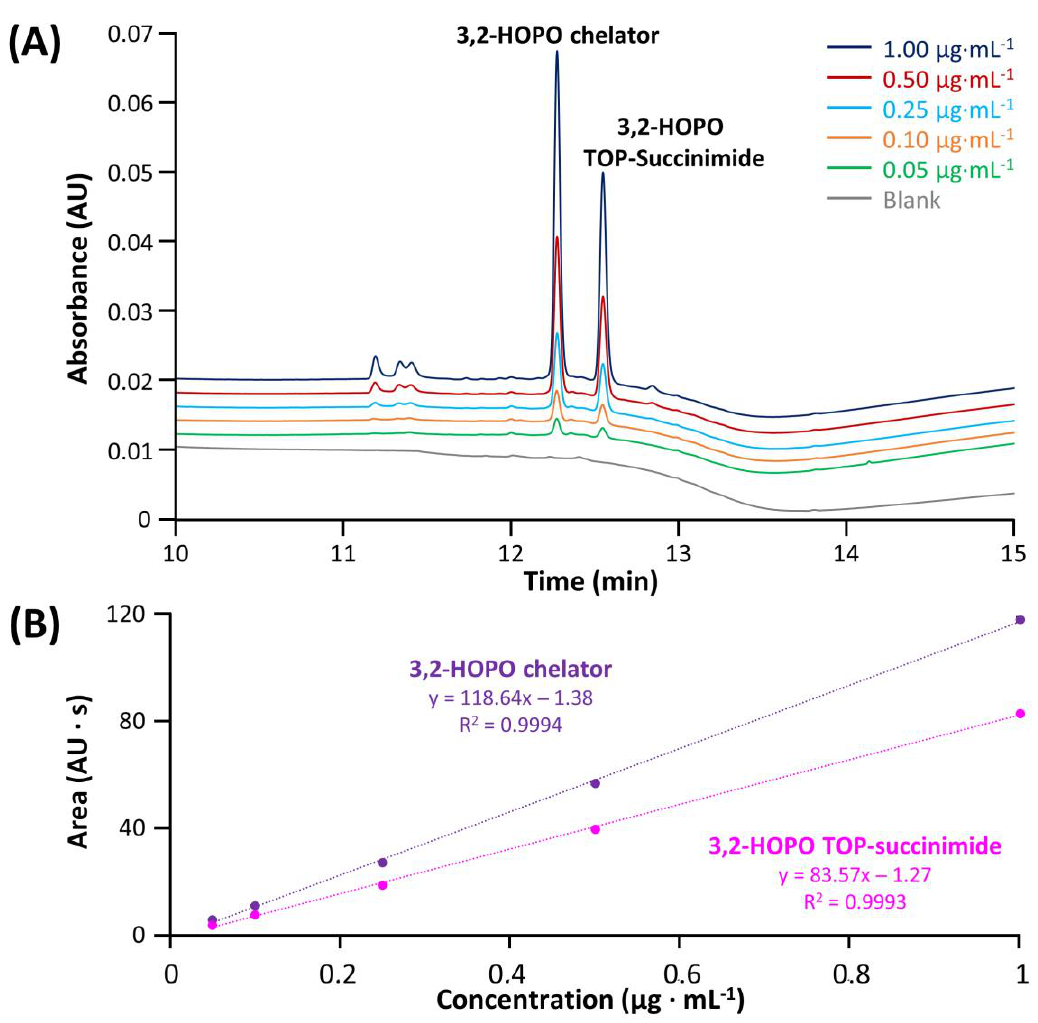
Figure 5. Chromatograms obtained after the filtration protocol for ACC samples ( A ) spiked with different concentrations of 3,2-HOPO chelator and 3,2-HOPO TOP-Succinimide and ( B ) resulting calibration lines with triplicate injections.